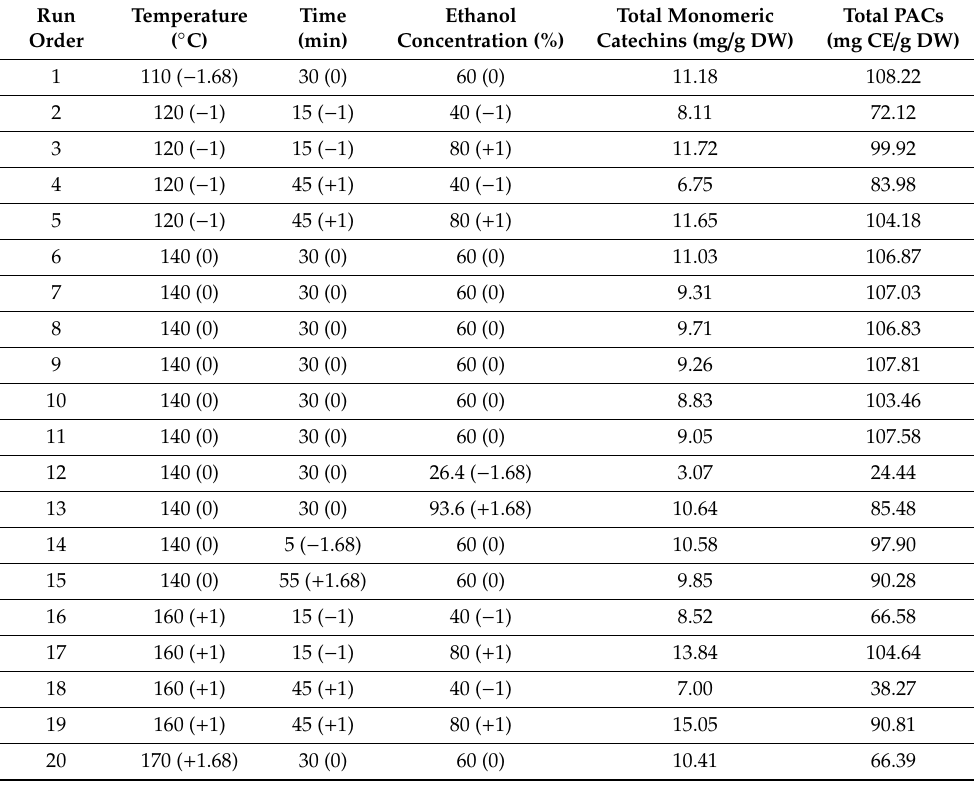
Table 1. Central composite design (CCD) arrangement for microwave-assisted extraction of PACs from grape seed.